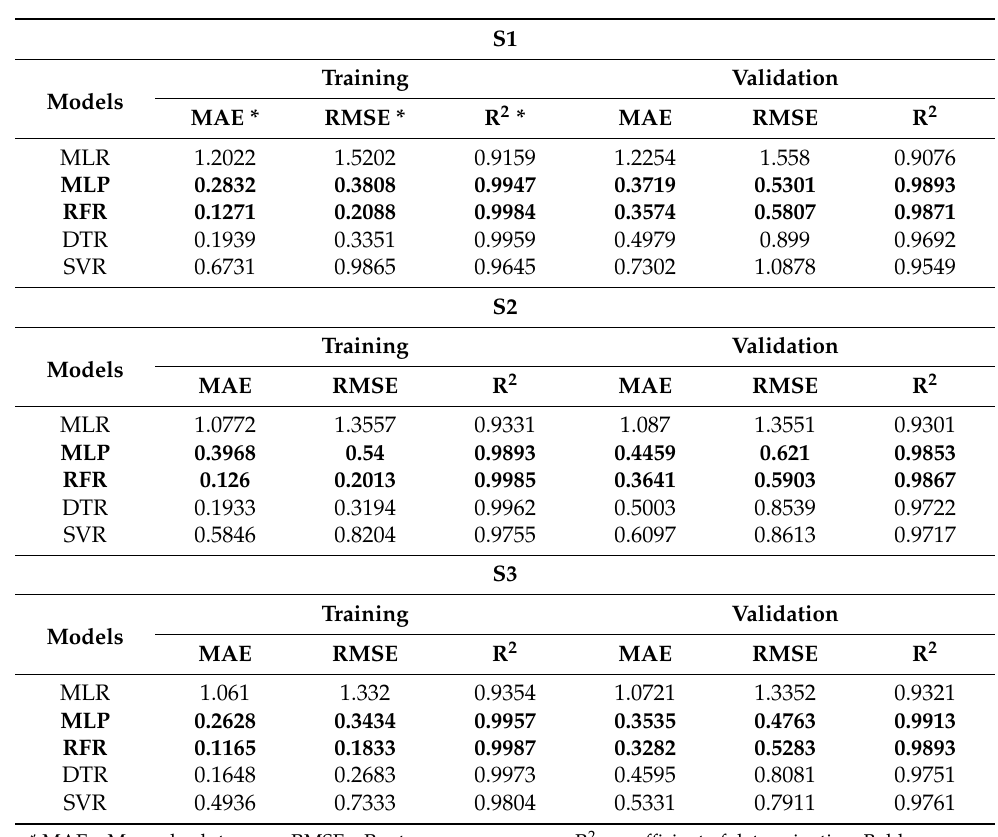
Table 4. The performance assessment of all the models along with S1, S2, and S3 input data set during IAT